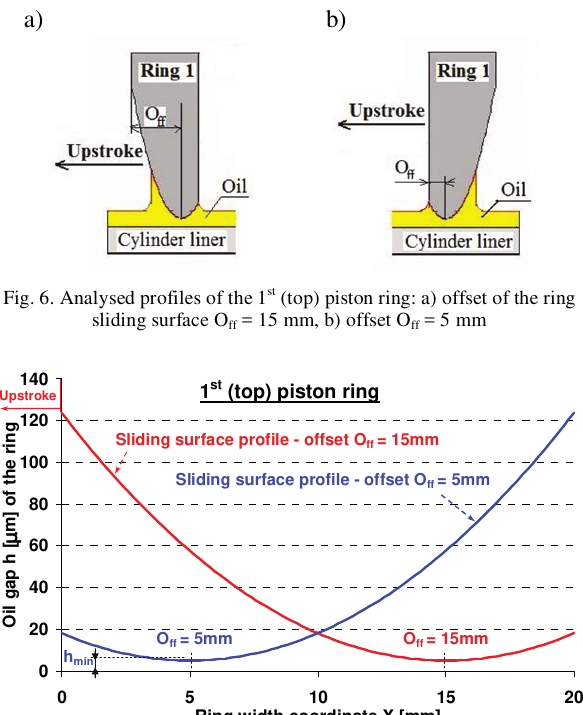
Fig. 7. Comparison of two chosen profiles of the 1 st (top) piston ring: chosen offsets of the ring sliding surface O ff = 15 mm and O ff = 5 mm; h min – minimum oil film thickness